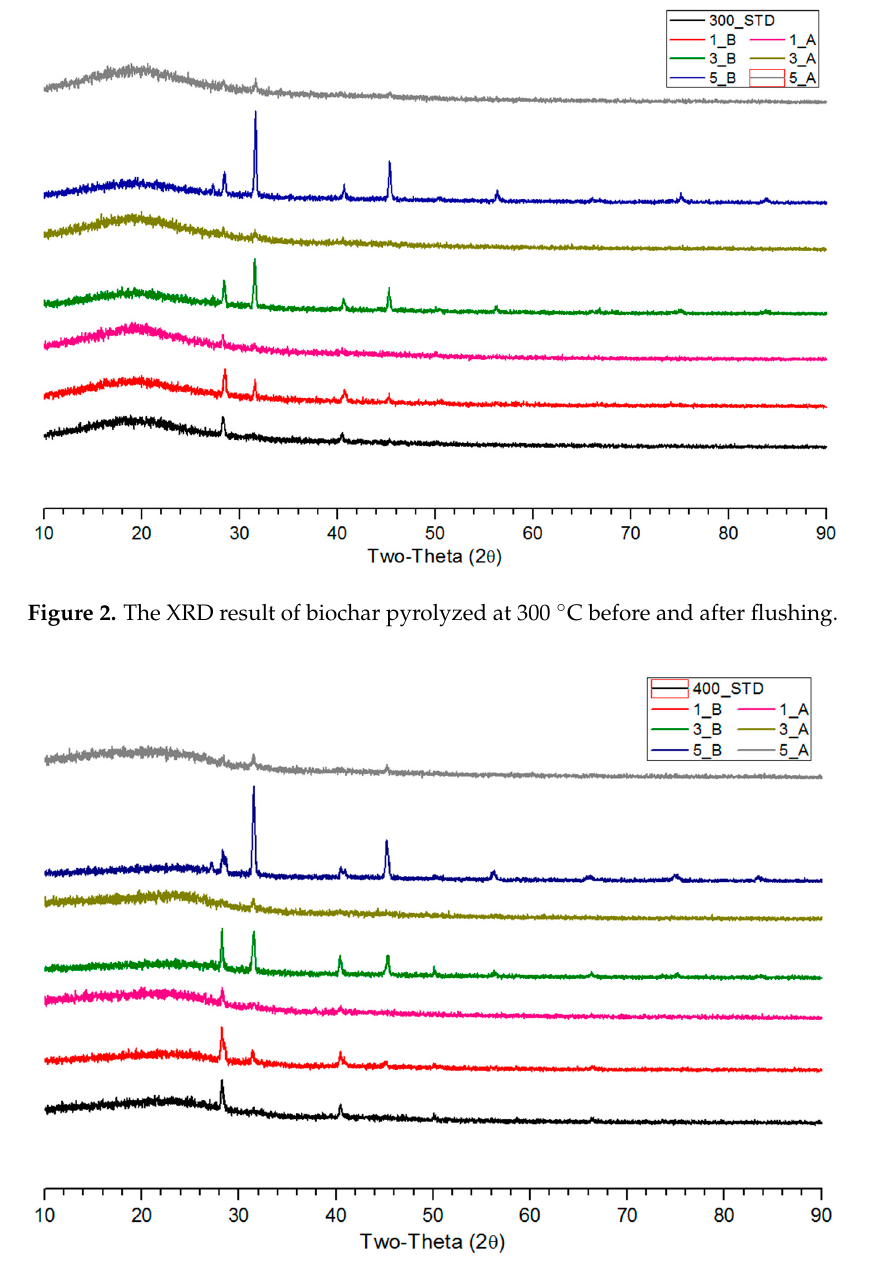
Figure 3. The XRD result of biochar pyrolyzed at 400 °C before and after flushing.